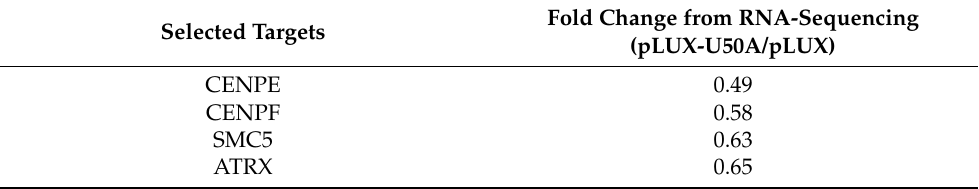
Table 4. Fold change of mitosis-related genes in RNA-sequencing